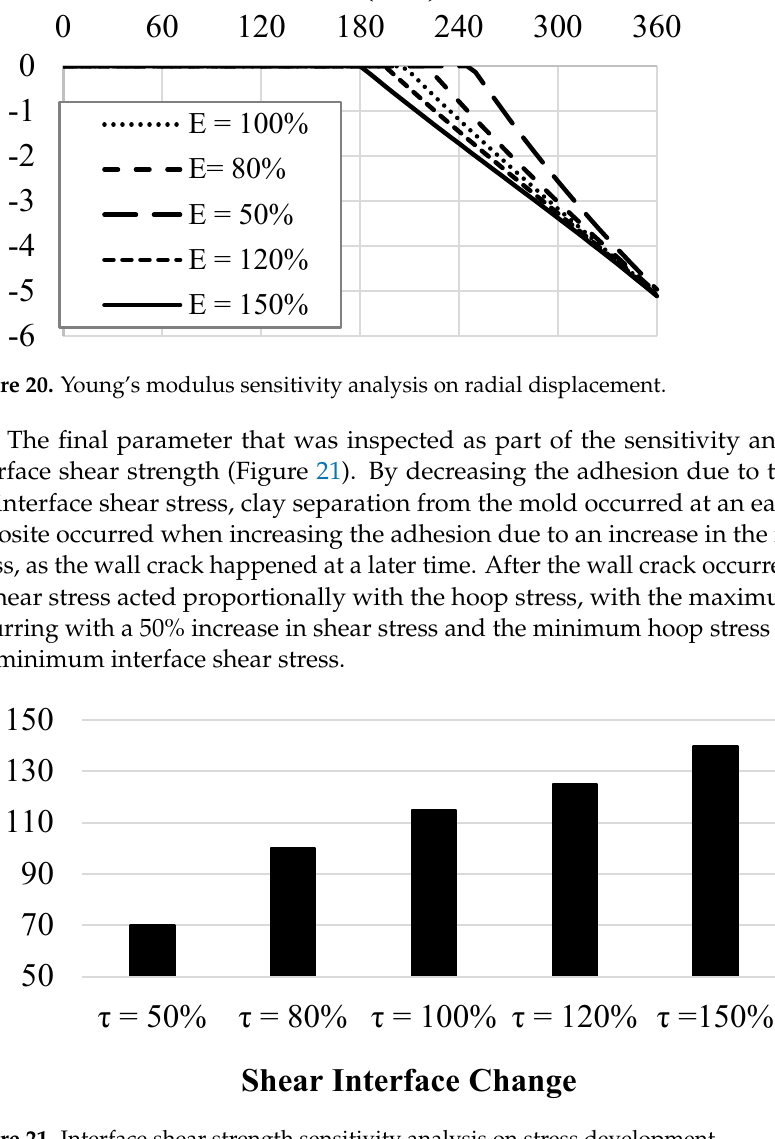
Figure 21. Interface shear strength sensitivity analysis on stress development.